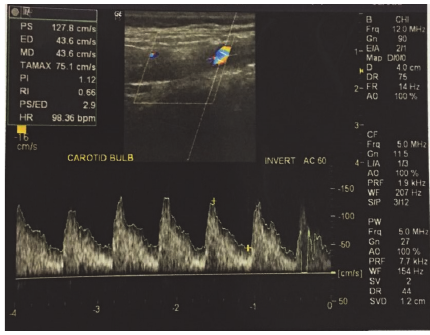
Figure 1: Carotid artery Doppler of the patient.